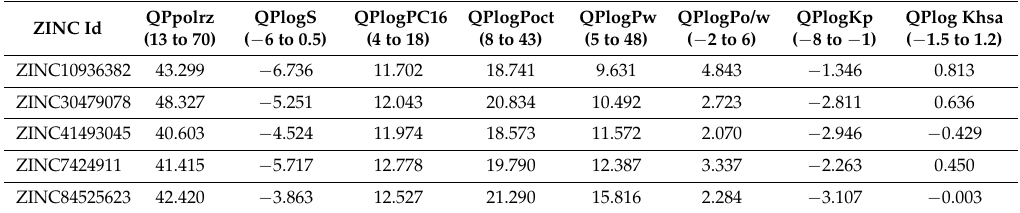
Table 3. The ADME/T properties of the top 5% selected compounds by a XP (Extra Precision) docking scores.